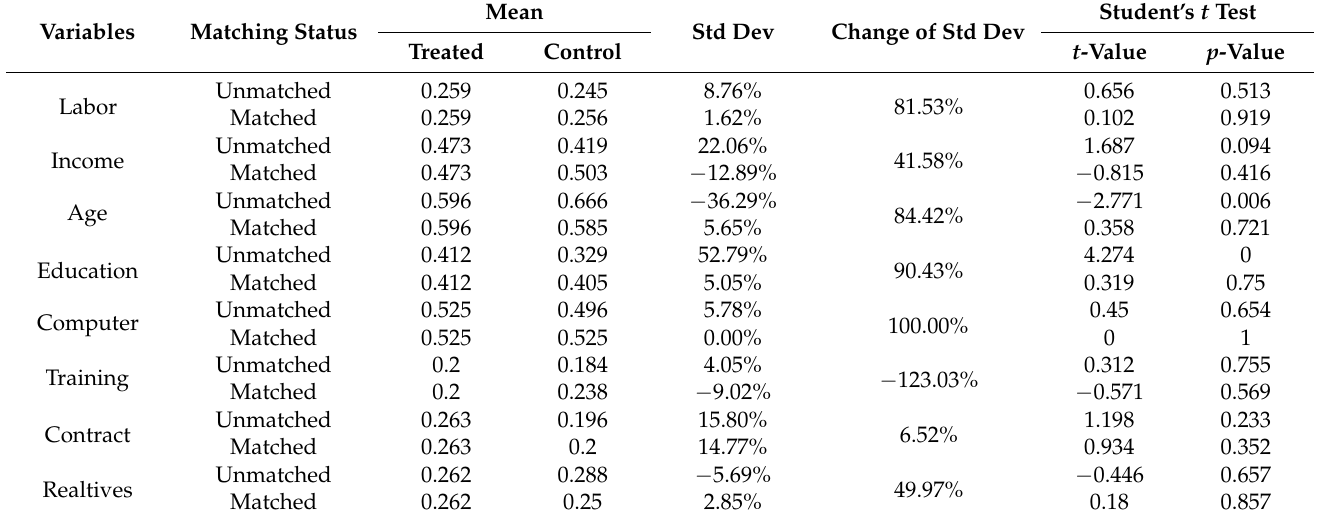
Table 5. Balance test results.